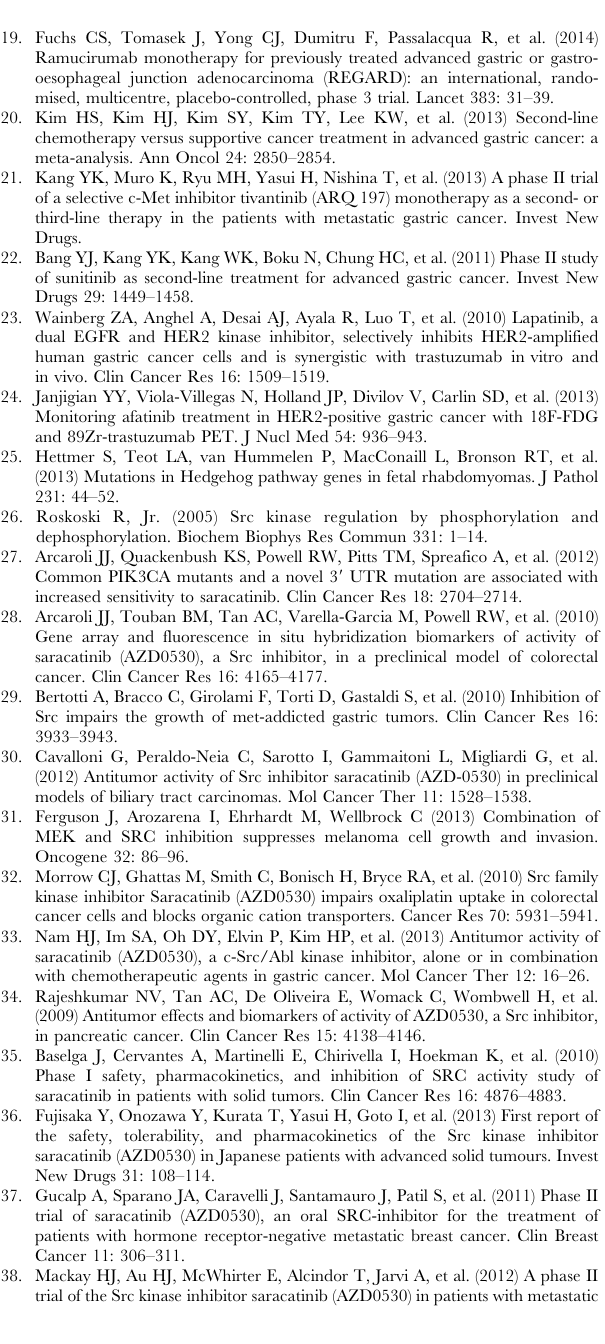
(TIFF) Figure S3 Growth inhibition curves in the parental OE19 and in the two Src -mutant LR subclones after increasing dose of saracatinib. Values were presented as relative cellular viability relative to vehicle-treated controls with the mean 6 S.E. of quadruplicate from a representative experiment. There was no statistical significance in terms of cell viability between cell lines. Table S1 Next-generation sequencing panel in 8 cell lines including parental OE19 and 7 lapatinib-resistant